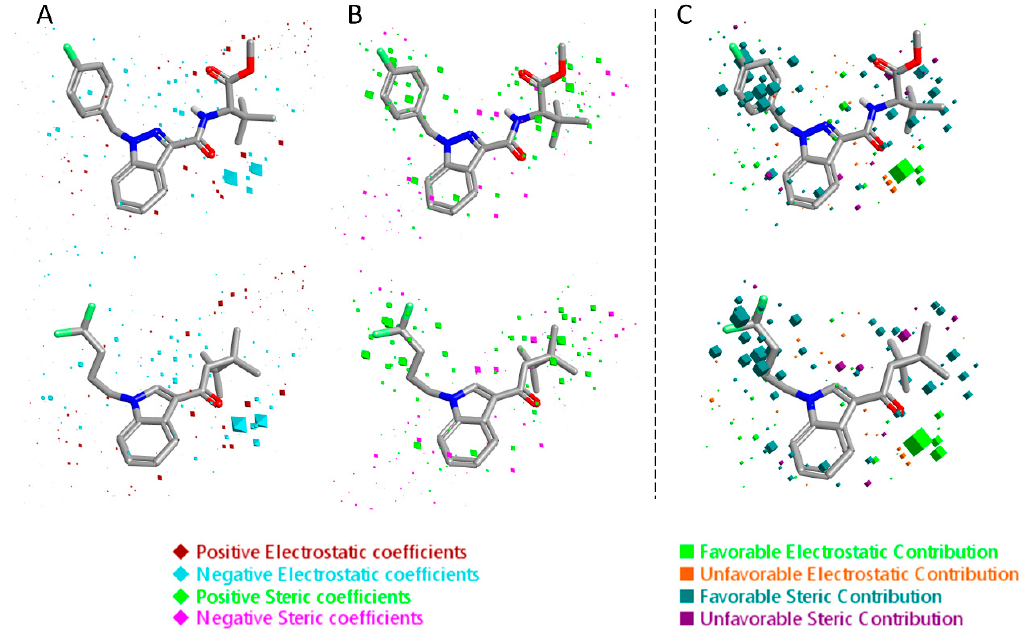
Figure 7. Electrostatic and steric coefficients for the CB 2 model. ( A ) Electrostatic coefficients superimposed to MDMB-FUBINACA (up) and XLR-12 (down). ( B ) Steric coefficients superimposed to MDMB-FUBINACA (up) and XLR-12 (down). ( C ) Contributions to predicted affinity for MDMB-FUBINACA (up) and XLR-12 (down).